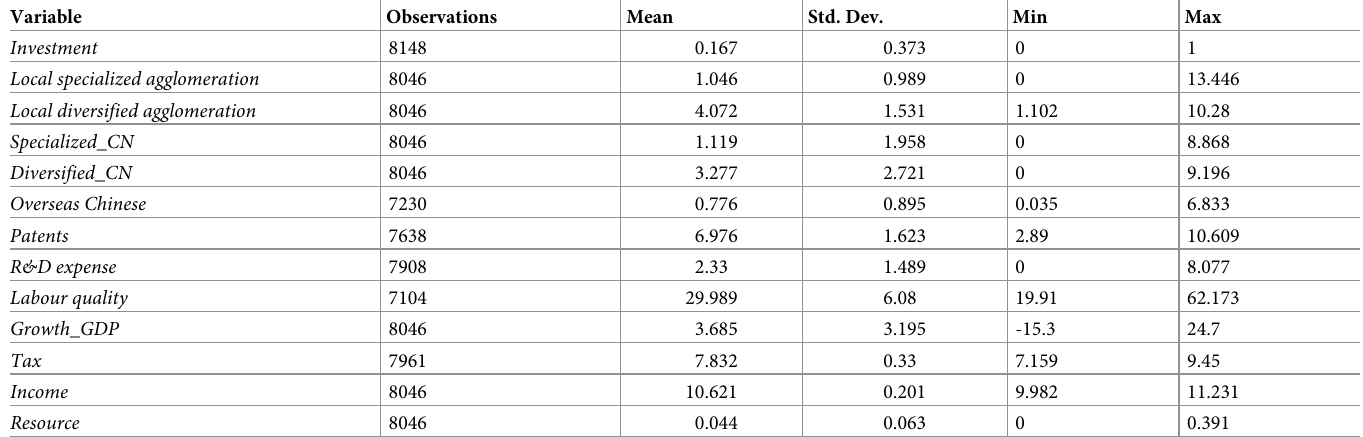
Table 3. Descriptive statistics for